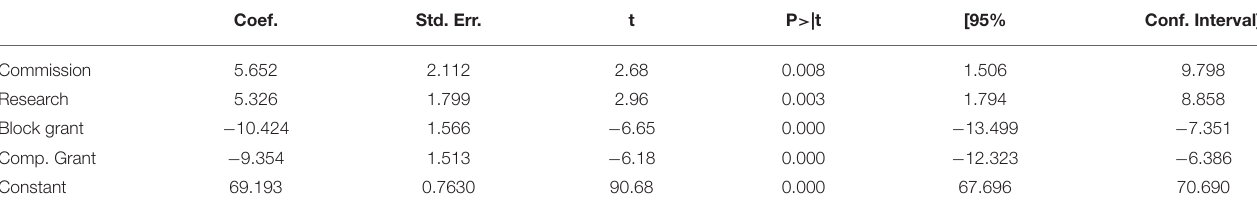
TABLE 4 | PART scores (OLS) by “commission,” model 1. Coef.